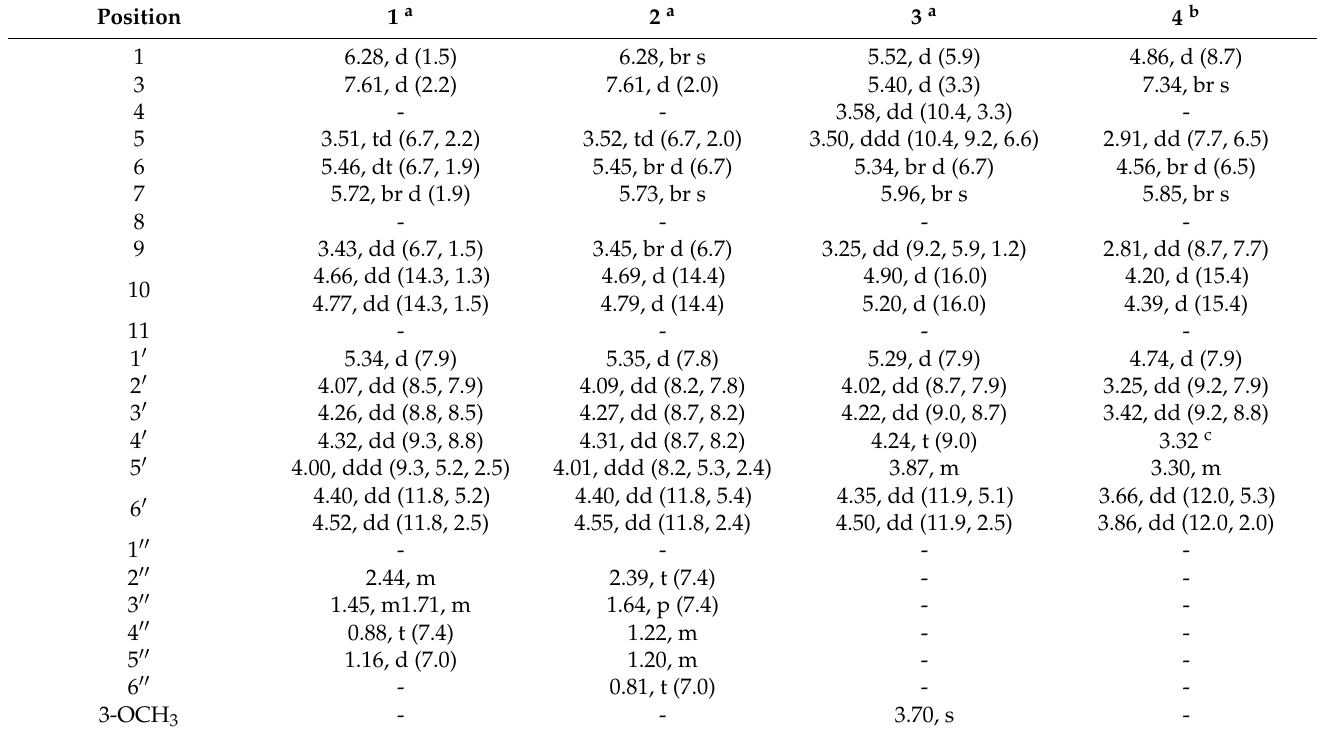
Table 2. 1 H-NMR spectroscopic data ( δ H , multiplicity ( J in Hz)) for compounds 1 – 4